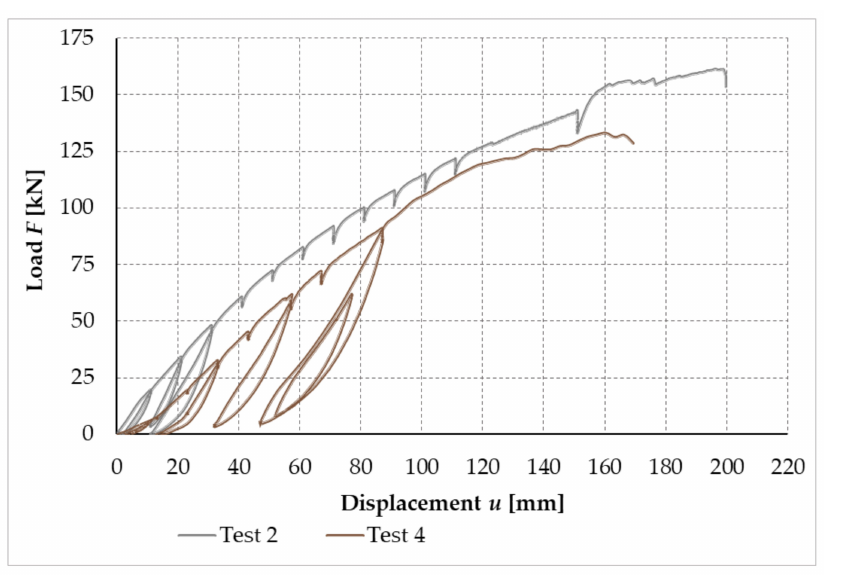
Figure 23. Load–displacement curves of experimental testing, test sample no. 2 and test sample no. 4 (experiment setup no.